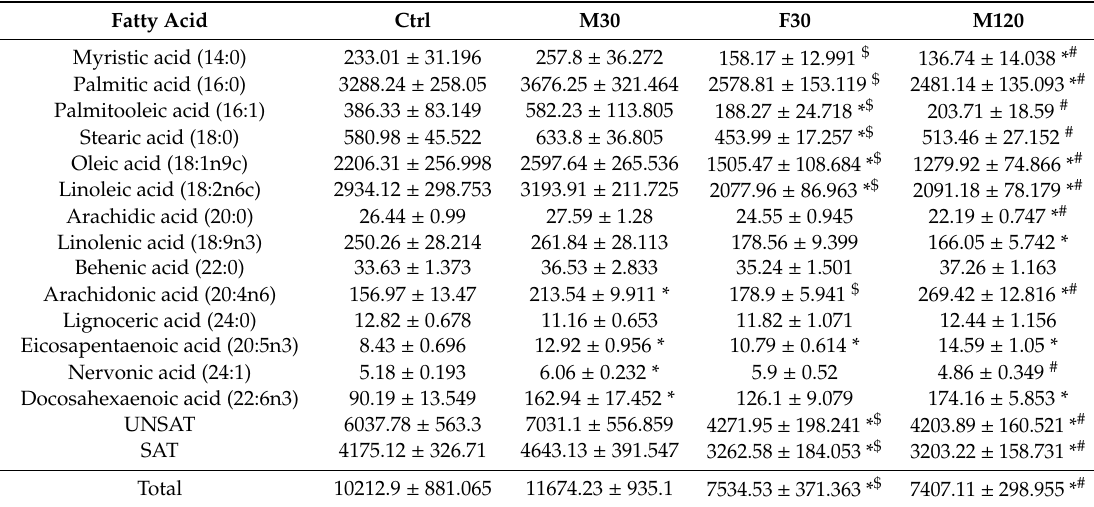
Table A6. The right ventricle TG—fatty acid composition (nmol / g of wet